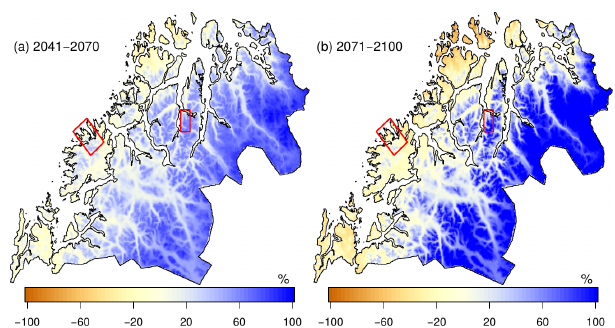
Figure 13. Projected change in the frequency of zero crossings dur- ing winter (October–April) between 1981–2010 and (a) the near future (2041–2070) and between 1981–2010 and (b) the far future (2071–2100), based on minimum and maximum temperature.